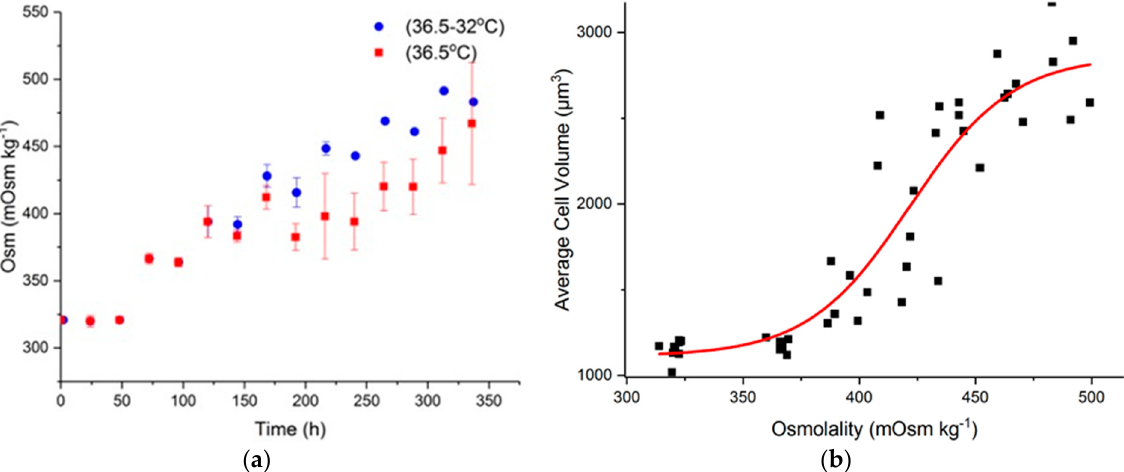
Figure 7. ( a ) Osmolality profile for the bioreactor runs at 36.5 °C (blue) and with a temperature shift to 32° C on day 5; ( b ) Average cell volume against culture osmolality for both bioreactor datasets.